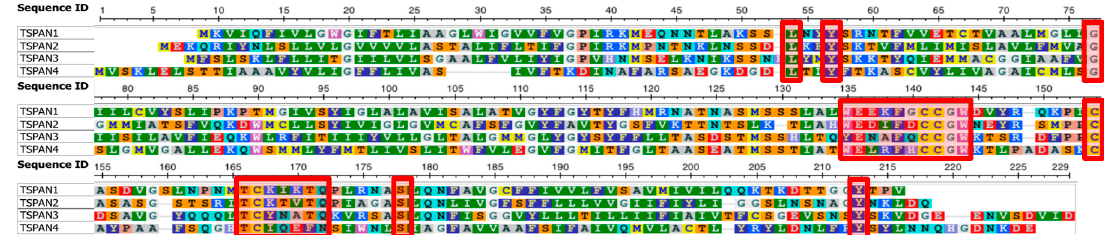
Figure 3. Multiple sequence alignment of subgroup 1 tetraspanins in E. histolytica . Conserved residues and regions mentioned in the main text are indicated with red boxes. The figure was generated using the NCBI MSA Viewer [40].